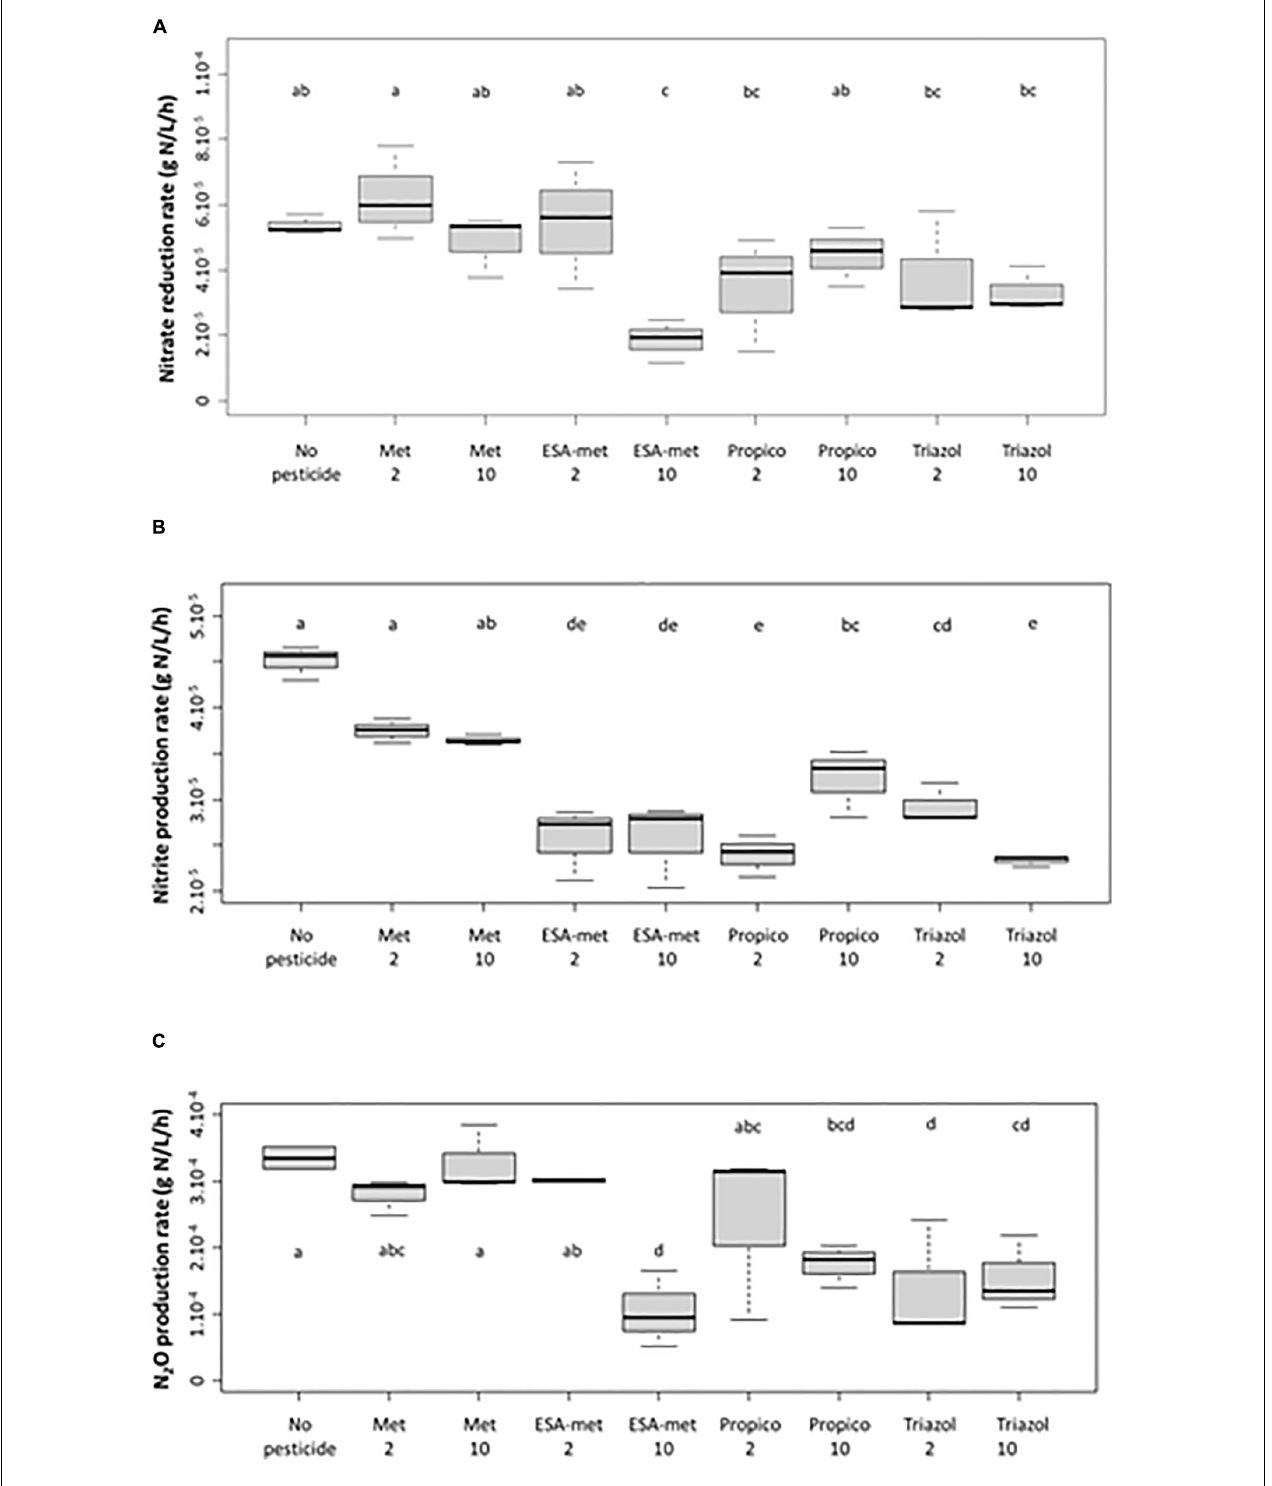
FIGURE 1 | Impact of pesticides and metabolites on the potential denitrification activity (batch experiments) measured as the impact on nitrate (as NO 3 − ) reduction (A) , nitrite (as NO 2 − ) production (B) , and N 2 O production (C) rates. Significant differences between conditions were searched applying the Kruskal-Wallis non-parametric test and are mentioned as a, b, c, d, and e letters. No pesticide: control (absence of pesticides or metabolites); Met: metolachlor; ESA-met: ESA-metolachlor Propico: propiconazole; Triazol: 1,2,4 triazole. 2 and 10 are pesticide or metabolite concentrations in µ g/L. No nitrate reduction nor nitrite and N 2 O production took place in abiotic test batch (data not